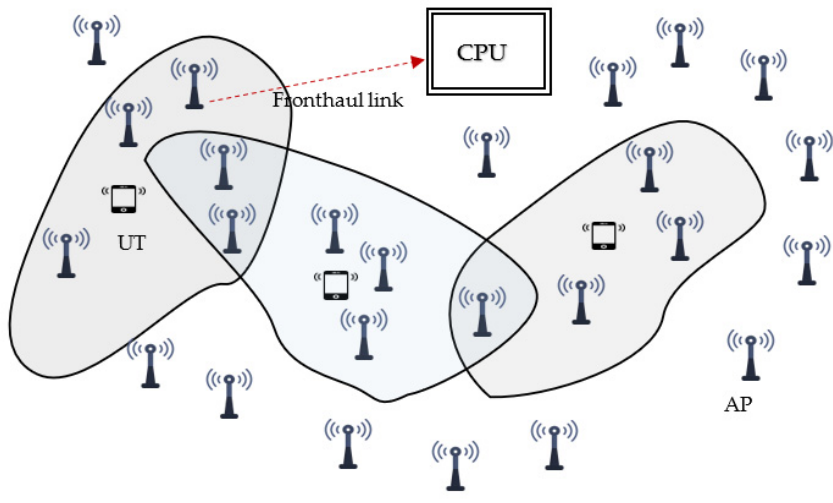
Figure 1. User-Centric Cell-Free system with dynamic cooperative